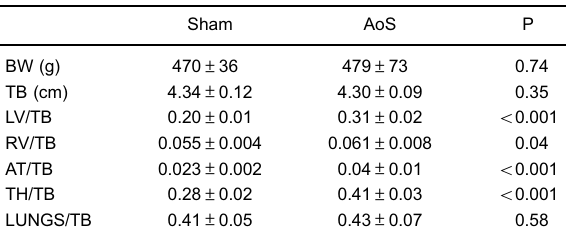
Table 1. Post-mortem structural study of animals submitted to simulated surgery (Sham) and animals submitted to aortic stenosis surgery (AoS).